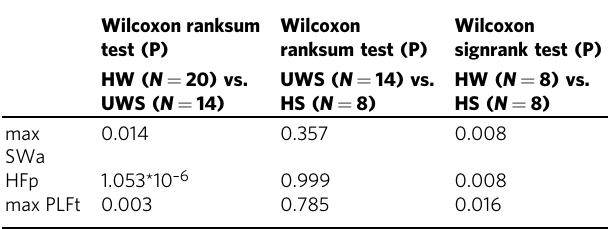
Fig. 3 Slow-wave amplitude, high-frequency suppression and PLF duration correlate in UWS patients. On the left, the correlation between the maximal amplitude of the evoked slow wave (max SWa) and the maximal level of high-frequency (>20 Hz) power suppression (max SHFp) is shown. On the right, the correlation between the timing of the maximum high-frequency suppression (max SHFt) and the timing of the last signi fi cant time point of phase-locking (max PLFt) is shown. For both correlations, the coef fi cient of determination R 2 and the signi fi cance level P are reported. White squares and black dots represent BA6 and BA7 stimulation, respectively